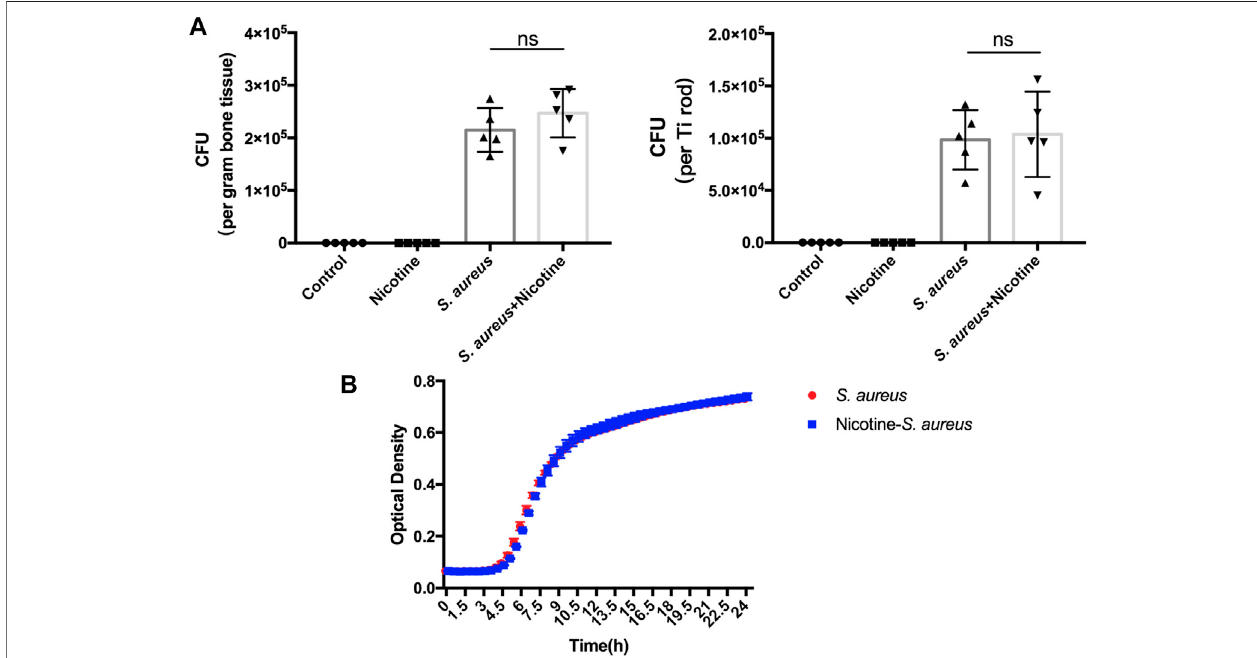
FIGURE 4 | Nicotine showed no impact on the proliferation of S. aureus . (A) Quantitative analysis of S. aureus dwelling in Ti rods or in the bone tissue. (B) Growth curves of S. aureus and nicotine – S. aureus . ns: p S 0.05.